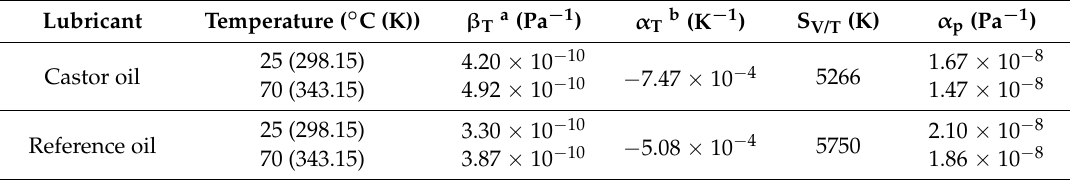
Table A1. Pressure-viscosity coefficient ( α p ) of Castor and Reference oil.